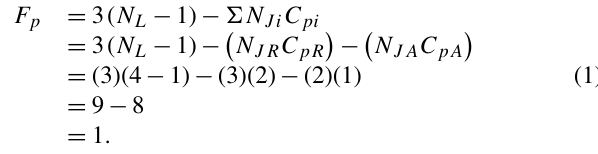
the connecting link with a revolute joint J R and a cam joint J A , respectively. The connecting link is adjacent to the frame with a revolute joint J R . The corresponding topology matrix is shown in Fig.